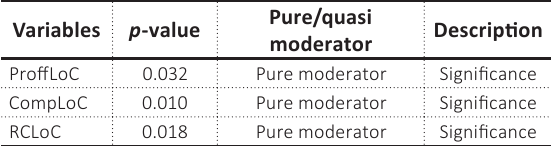
Table 3. p -value of Hypotheses 4, 5, and 6